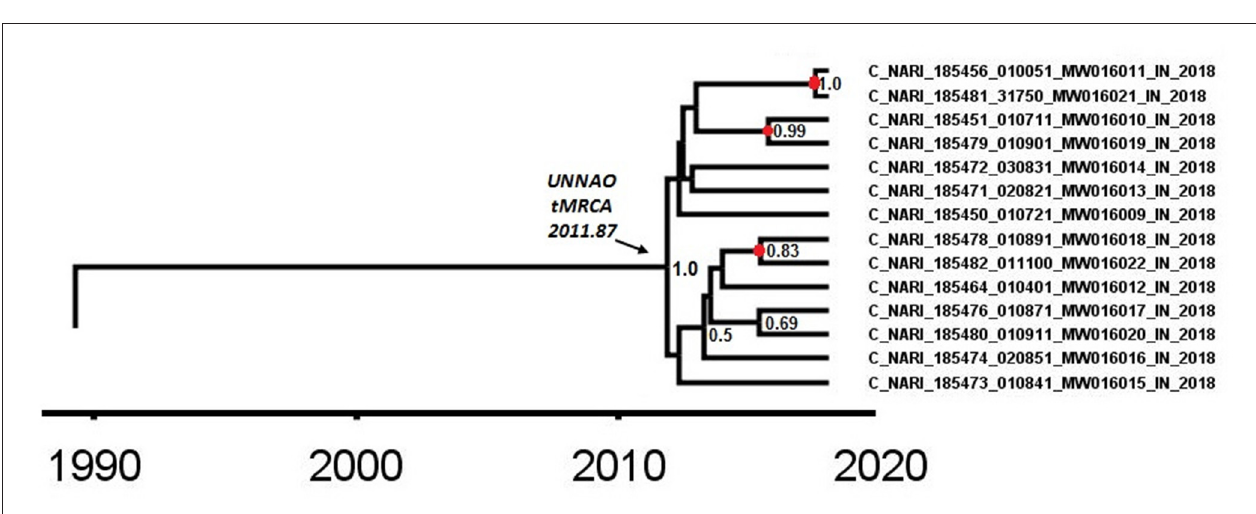
FIGURE 4 | A node from a pol gene region MCC tree was obtained after BEAST analysis. The node depicted by the arrow highlights the time (2011.87) of the most recent common ancestor for the Unnao transmission cluster. The nodes represented by the red circles depict the meantime of the recent transmission events identified by the cluster picker. Posterior probability values of ≥ 0.5 are